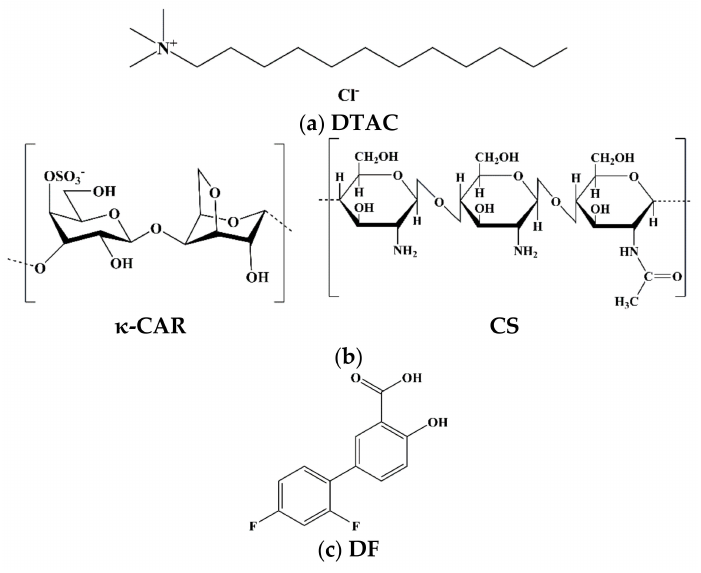
Figure 1. Chemical structures of the nanocapsule compounds: ( a ) surfactant; ( b ) polyelectrolytes (PE); and ( c ) diflunisal